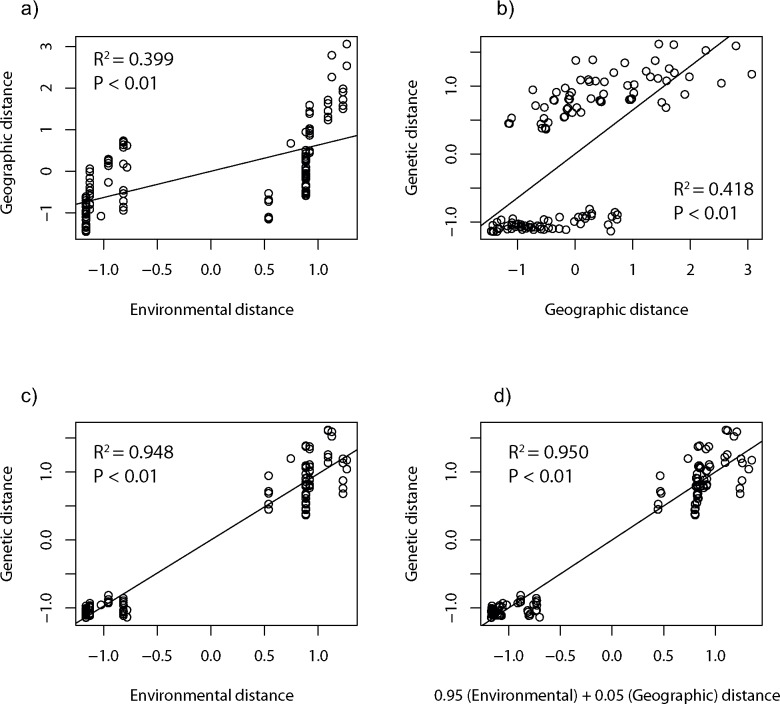
Results of multiple matrix regression with randomization (MMRR) analysis.Plots show a) the relationship of environmental and geographical distance, b) isolation-by-distance (IBD), c) isolation-by-environment (IBE), and d) multiple regression for the effects of geographical (ßDistance = 0.05) and environmental (ßEnvironment = 0.95) distances on genetic distance.